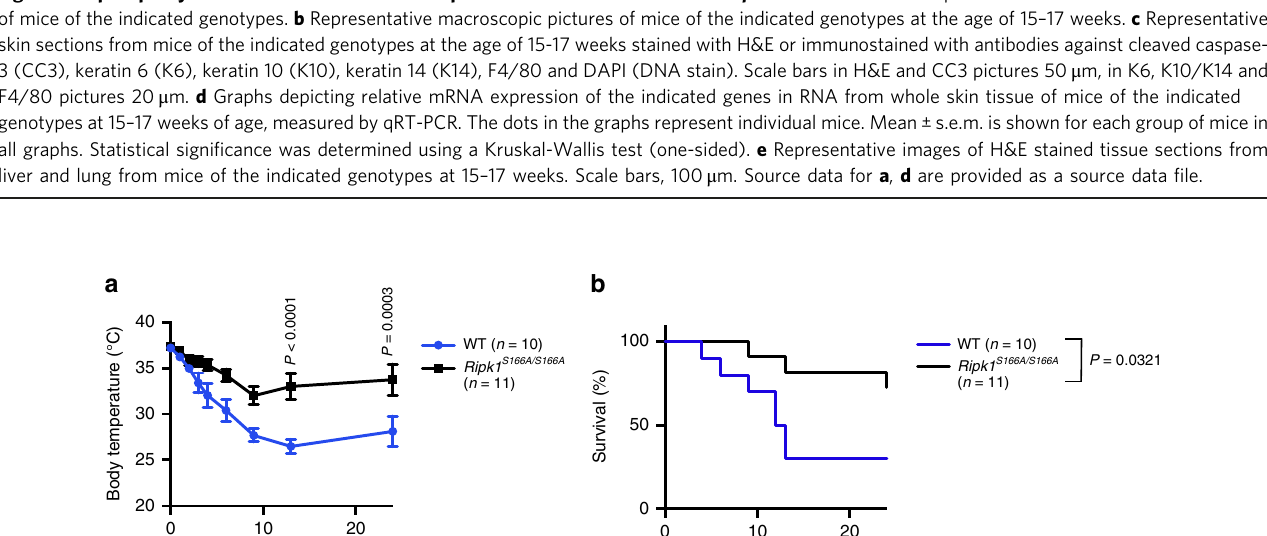
Fig. 6 S166 phosphorylation is required for RIPK1-dependent TNF-induced SIRS in mice. a Graph shows body temperature of mice of the indicated genotypes that were injected intravenously with 500 μ g kg − 1 body weight. Mean± s.e.m. is shown for each group of mice. Statistical signi fi cance was determined using a two-way ANOVA. b Graph shows survival of mice of the indicated genotypes. Statistical signi fi cance was determined using a Log-rank (Mantel-Cox) test (two-sided). Source data for a and b are provided as a source data fi